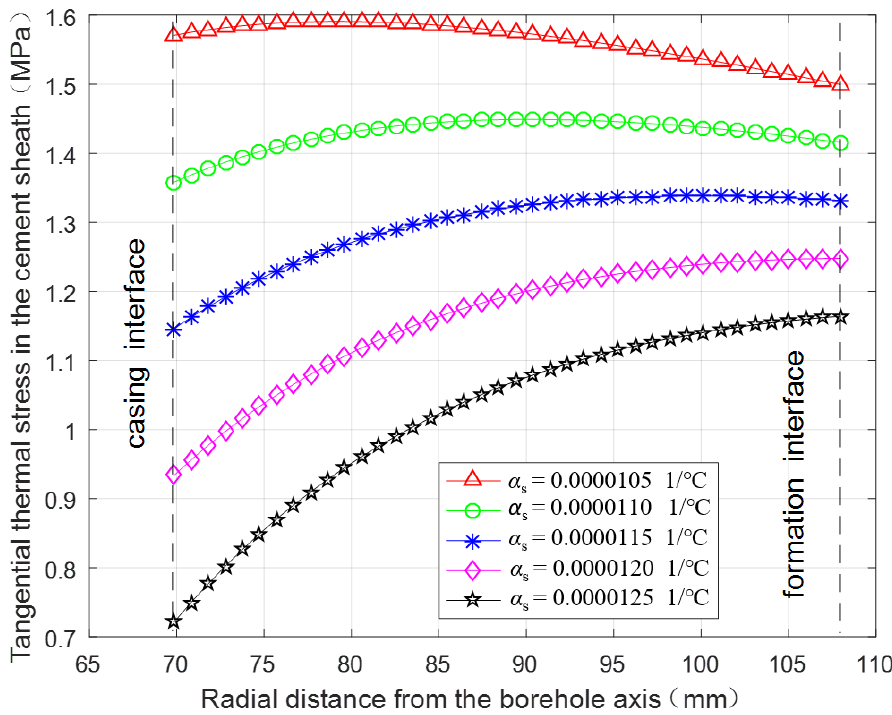
Figure 8. Radial distribution of the tangential thermal stress in the cement sheath under different linear thermal expansion coefficients of the casing.